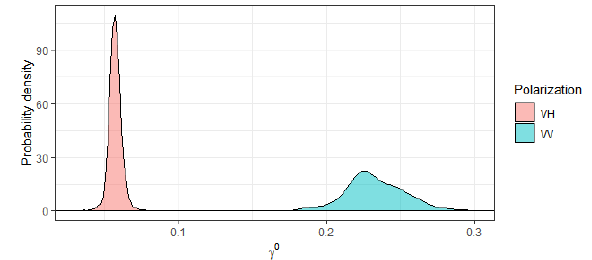
Figure 2: Mean 𝛾 0 for sampled points density distribution.